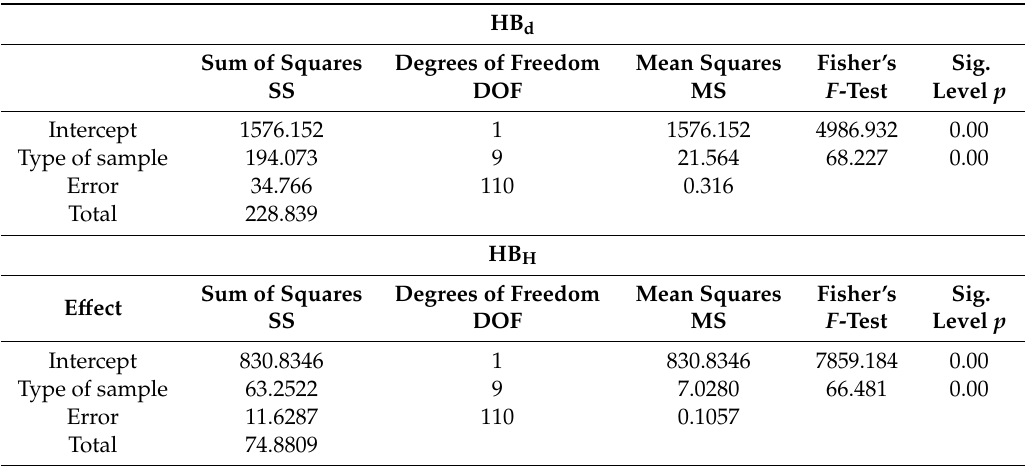
Table 3. The analysis of variance (ANOVA) results.